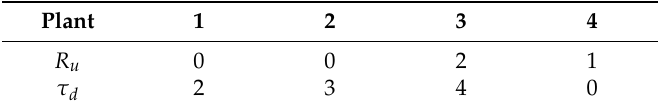
Table A1. Water inflow time delay between reservoirs.